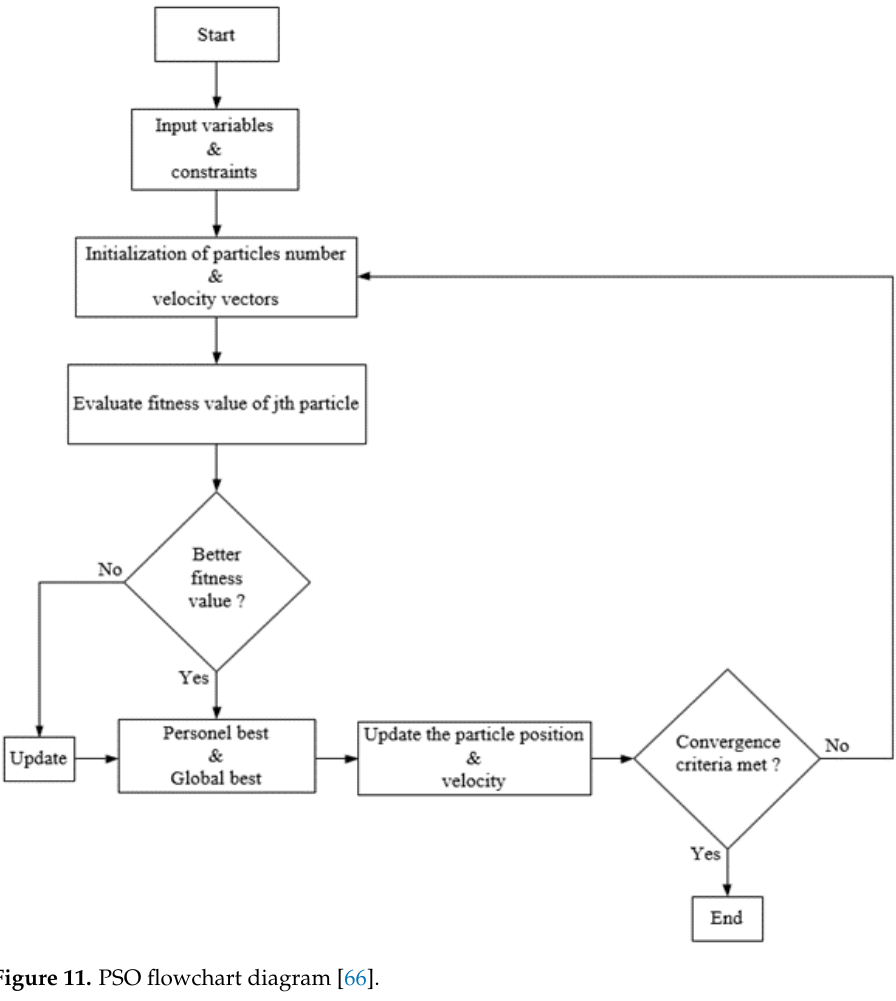
Figure 11. PSO flowchart diagram [66].